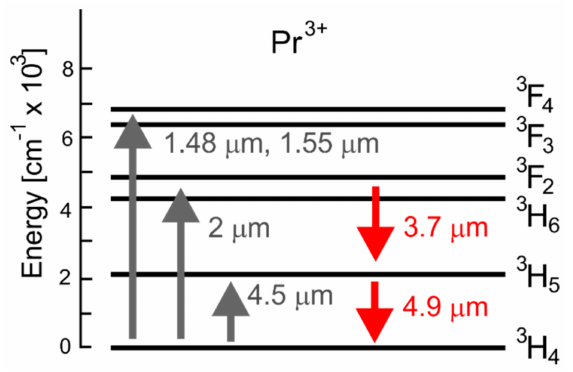
Figure 1. Energy level diagram for a praseodymium ion doped into selenide chalcogenide glass.